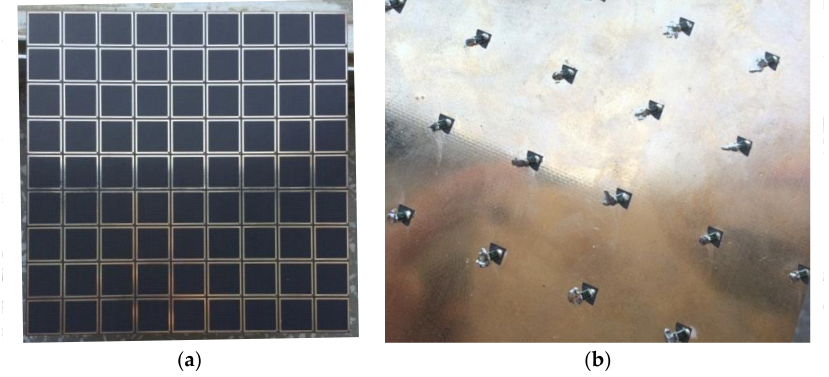
Figure 9. Photograph of the fabricated MS structure array on ( a ) front view ( b ) back view.